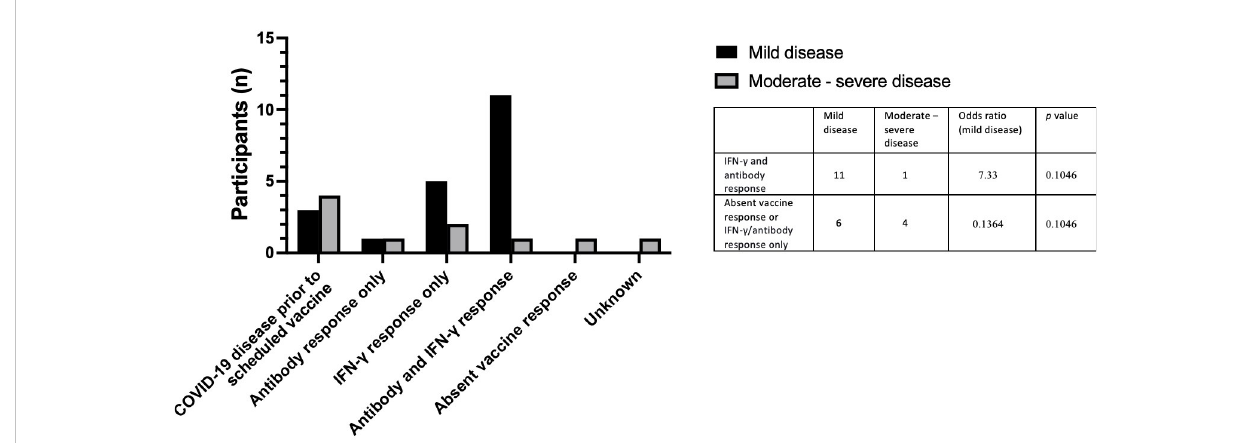
FIGURE 7 Vaccine responses in individuals testing positive for COVID-19 post vaccination in individuals who developed mild COVID-19 and individuals who developed moderate – severe